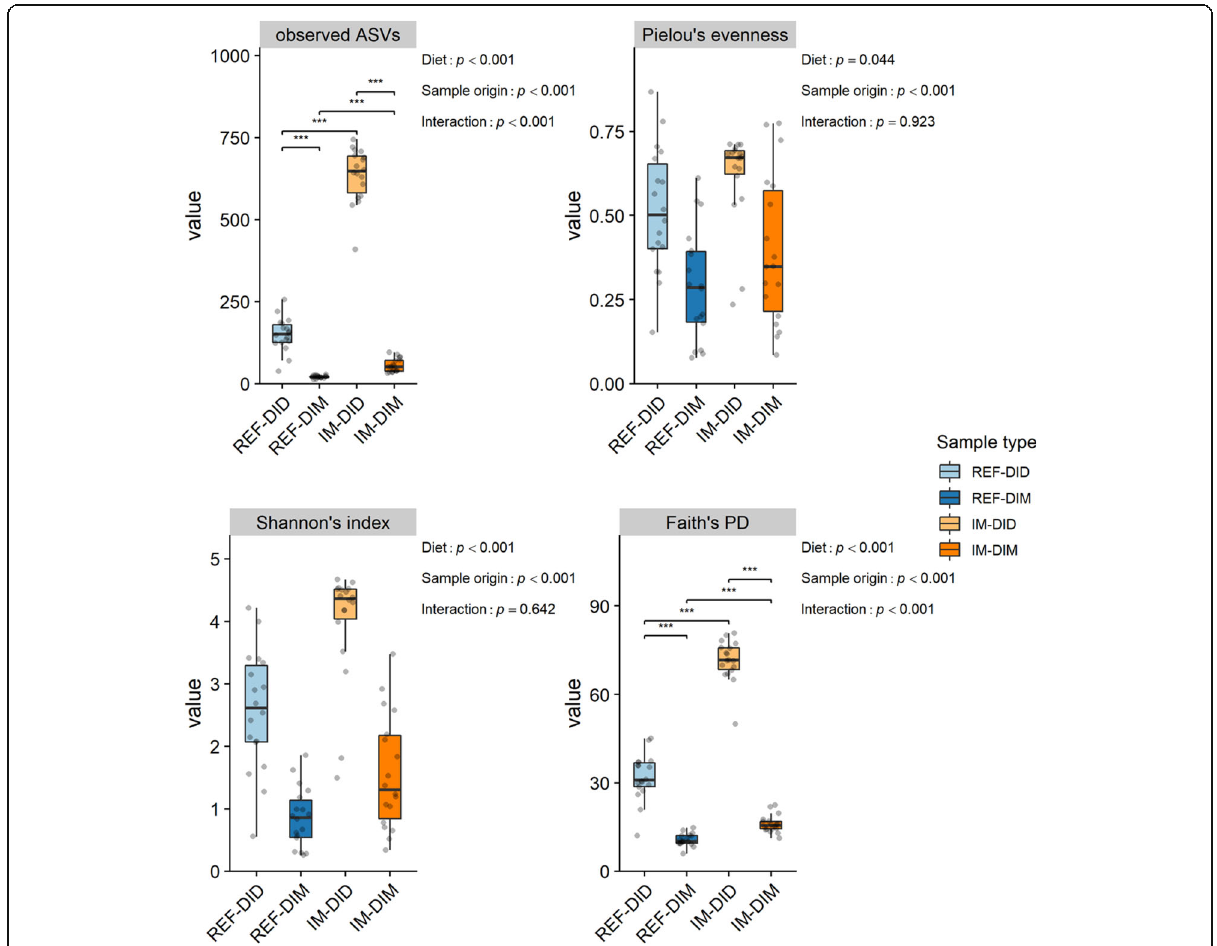
Fig. 3 The sample origin and diet effects on the alpha-diversity of distal intestinal microbiota in seawater phase Atlantic salmon. The p value of the main effects and their interaction are displayed on the top-right corner of each sub-plot. Asterisks denote statistically significant differences (*, p < 0.05; **, p < 0.01; ***, p < 0.001). PD, phylogenetic diversity; REF, reference diet; IM, insect meal diet; DID, distal intestine digesta; DIM, distal intestine